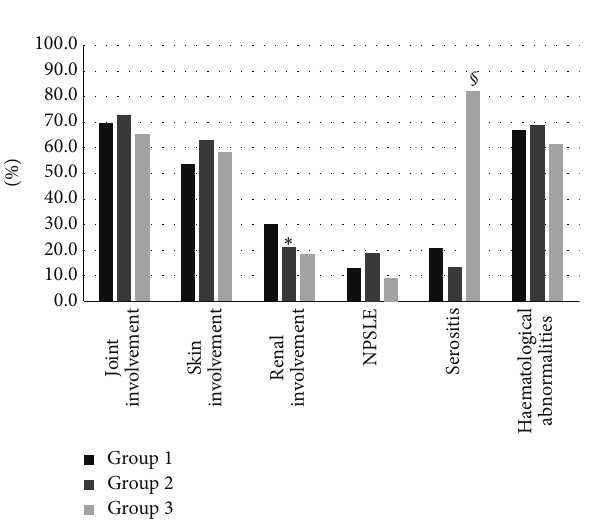
Figure 1: Clinical features of the 245 (62.3%) anti-dsDNA + (group 1),52(13.3%)anti-dsDNA ± (group2),and96(24.4%)anti-dsDNA − (group 3) SLE patients. ∗ 𝑃 = 0.001 group 1 versus group 2 and group 1 versus group 3; § 𝑃 < 0.0001 group 3 versus group 1 and group 3 versus group 2.